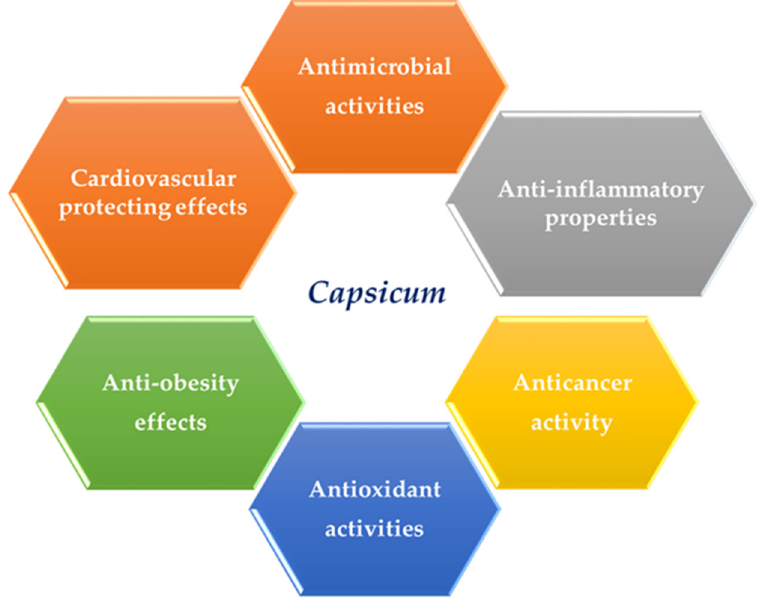
Figure 2. Summary of the biological activity of Capsicum .